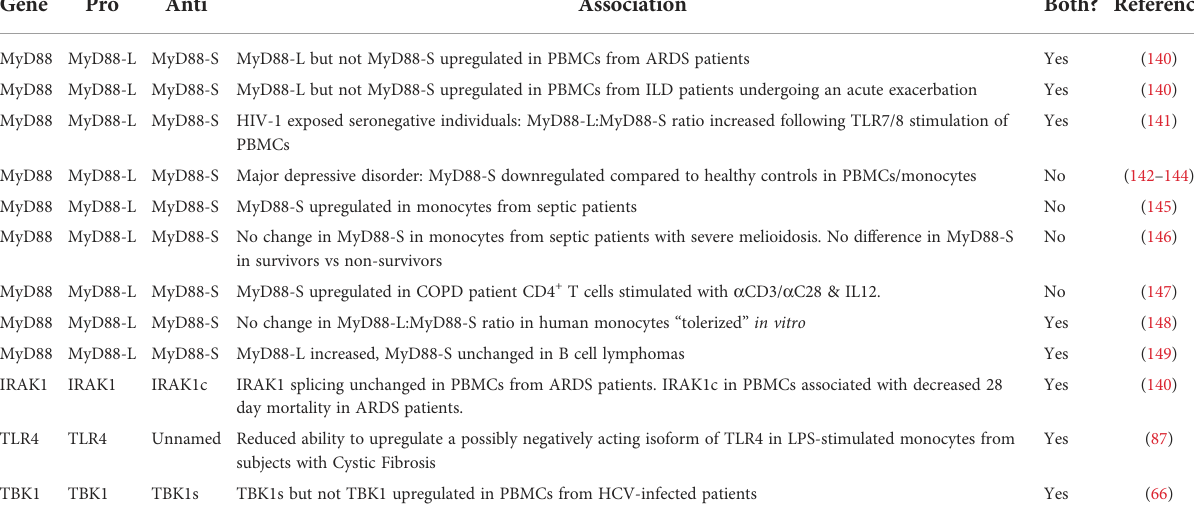
TABLE 2 Alternative isoform production associates with the incidence of infectious or in fl ammatory diseases. Gene Pro